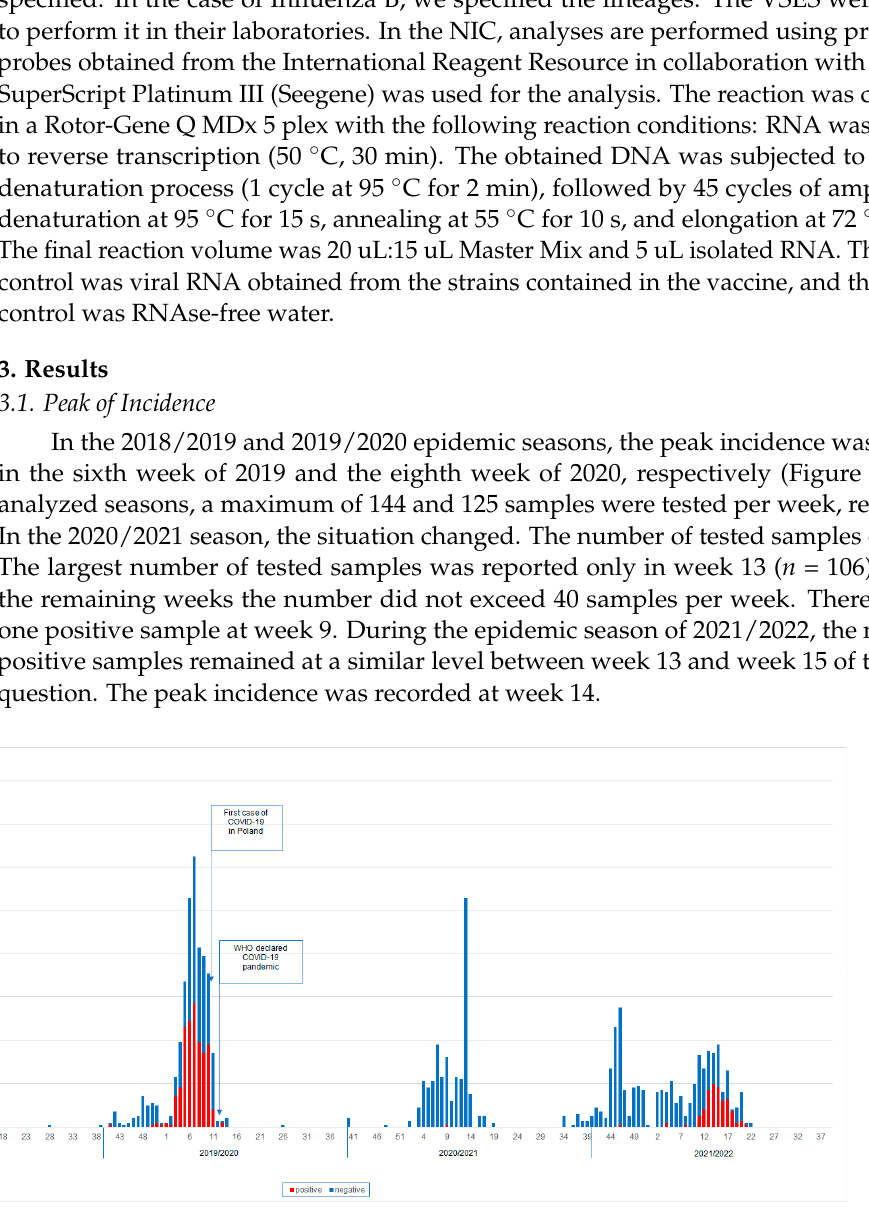
Figure 1. Weekly analysis of the number of positive and negative samples in the last four epidemic seasons.